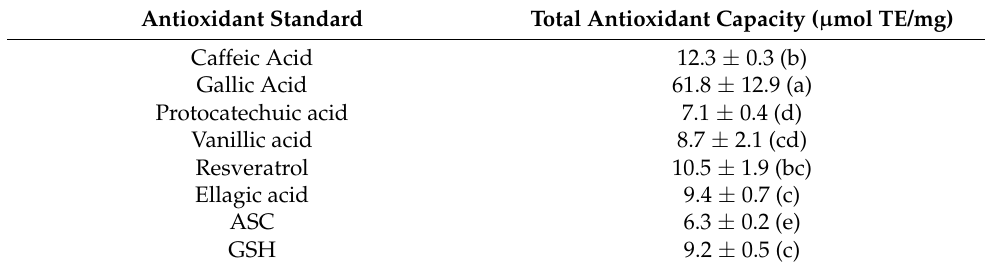
Table 1. TEAC reactivity of antioxidant standards. The ABTS scavenging activity of known antioxi- dants have been determined by TEAC assay and expressed as Trolox equivalent µ mol per mg. Values are means ± SD of three replicates. Different letters (a), (b), (c), (d), (e) indicate a statistical difference ( p < 0.05) according to